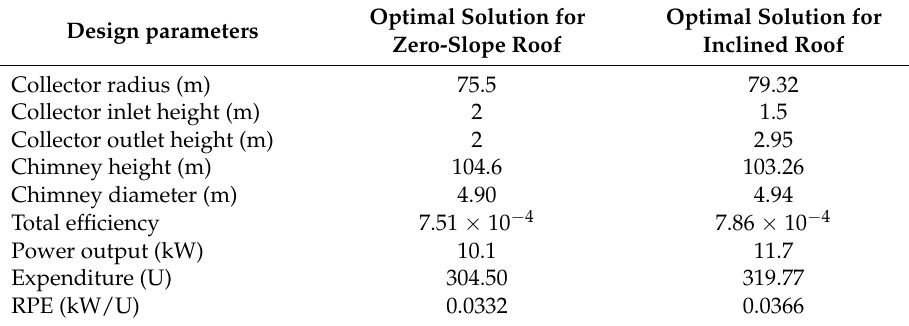
Figure 4. Tradeoff between the expenditure and power output for the Kerman SCPP. Table 2. Comparison of the design parameters and objective functions between selected solutions of the Pareto set and Kerman power plant.